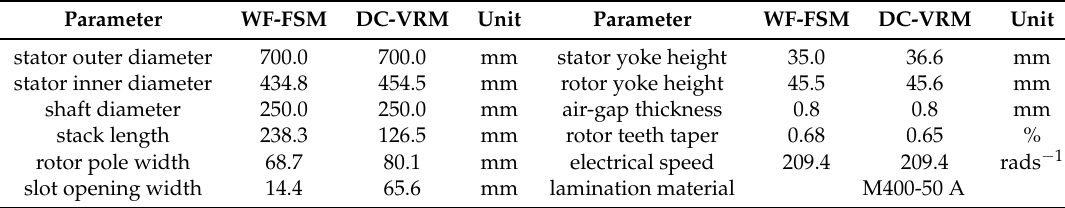
Table 1. Major design parameters of WF-FMMs.